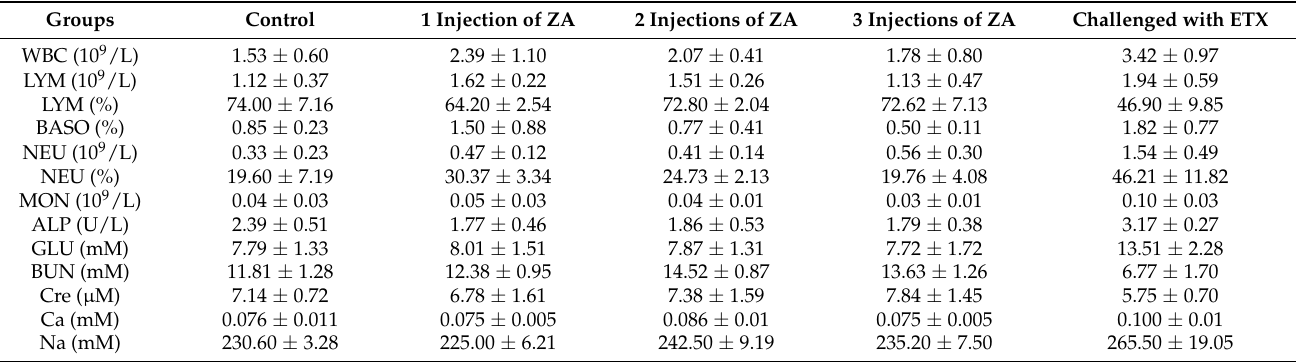
Table 1. Parameters of blood biochemical indexes and blood routine examination in